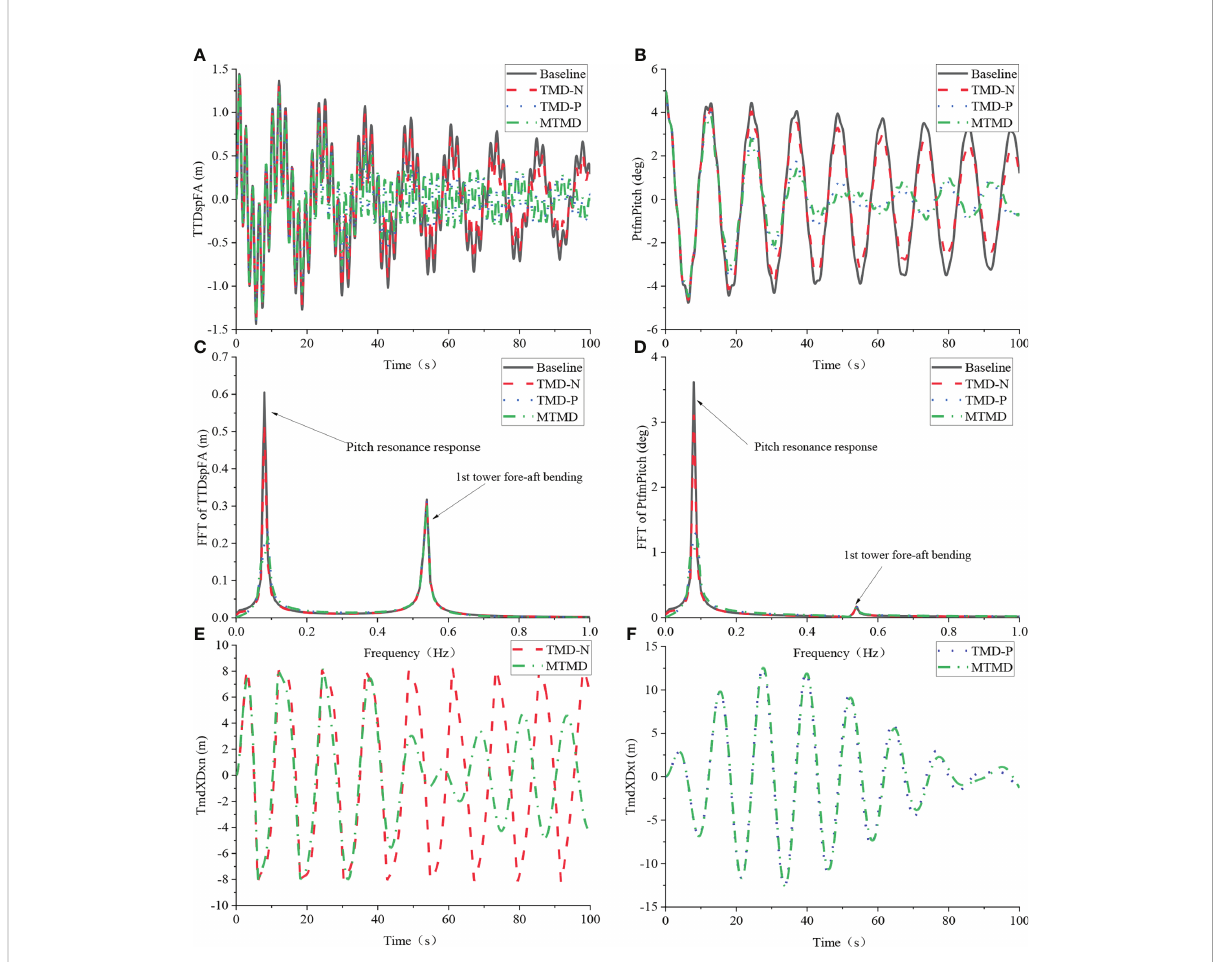
FIGURE 7 Comparison of free decay response between different optimal TMD con fi gurations. (A) Tower-top displacement; (B) Platform pitch angle; (C) FFT of Tower-top displacement; (D) FFT of Platform pitch angle; (E) TMD stokes of TMD in nacelle; (F) TMD stokes of TMD in